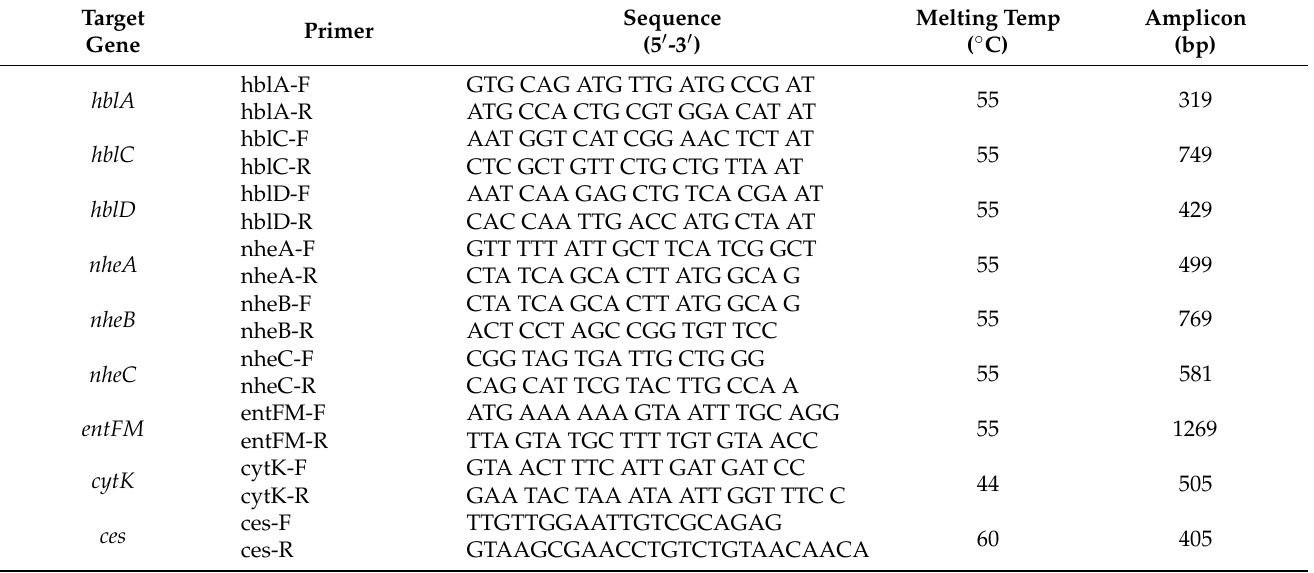
Table 1. Sequences of primers used in this